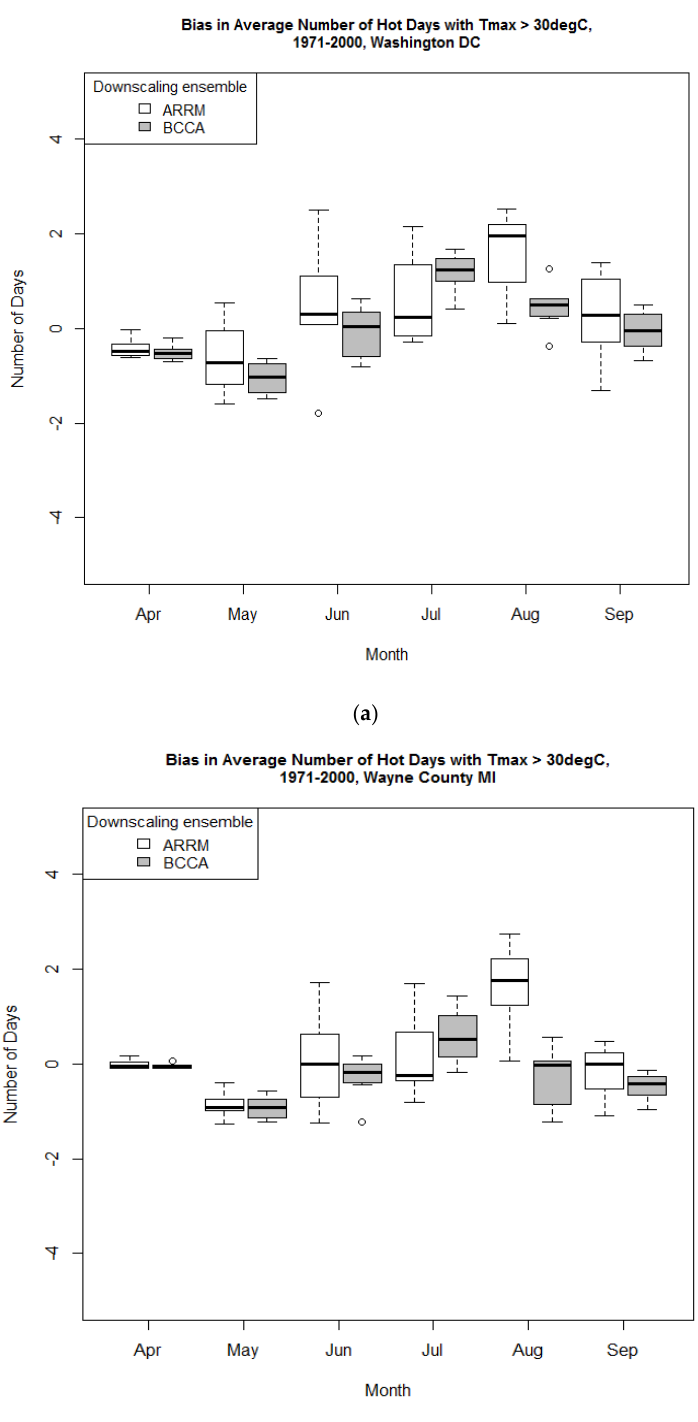
Figure 3. Absolute bias relative to Maurer02v2_1/8 observational dataset of the period mean HD30 in ( a ) Washington DC area and ( b ) Wayne County MI for 1971–2000 as represented by the ARRM and BCCA ensembles at 1/8° latitude resolution. Heavy line within each box plot represents the median.